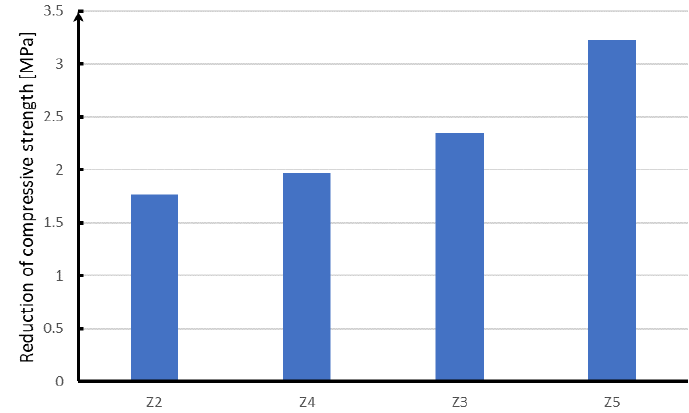
Figure 17 . Results of the frost resistance test. Figure 17. Results of the frost resistance test.